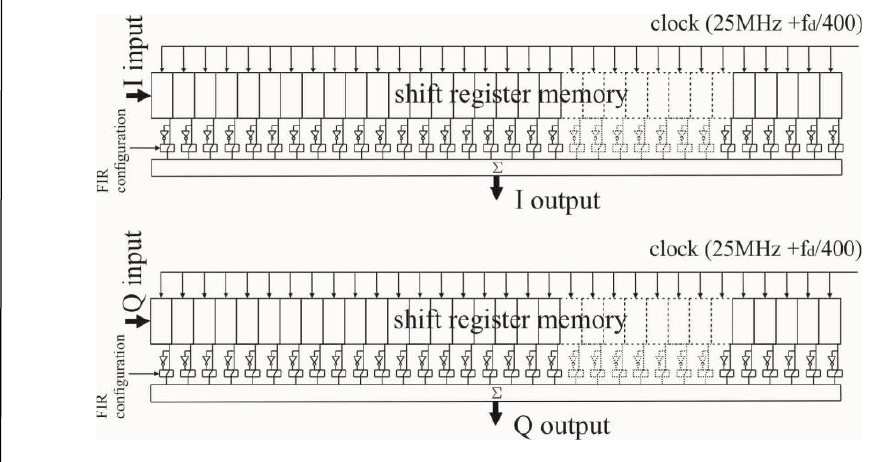
Figure 3 – Simplified schematic of the BPSK compression filter Рис. 3 – Упрощенная схема фильтра сжатия BPSK